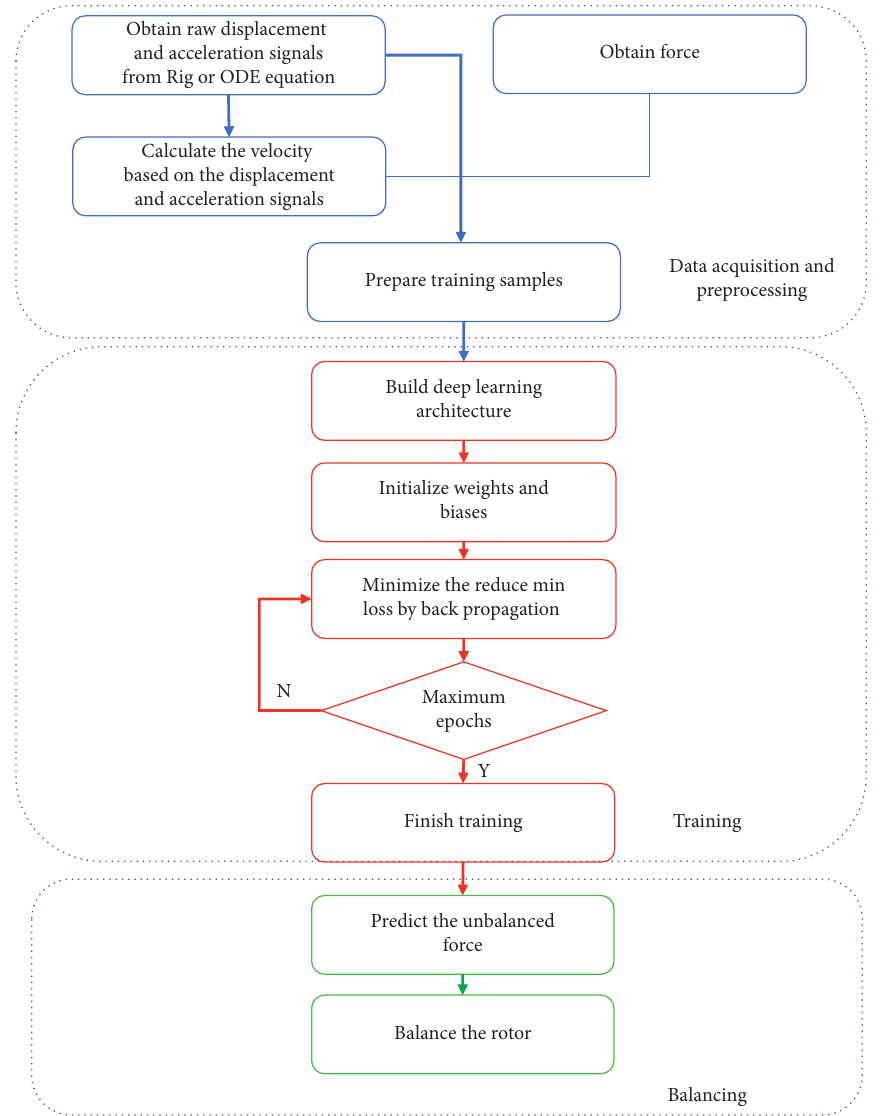
Figure 2: The flow chart of the proposed method.